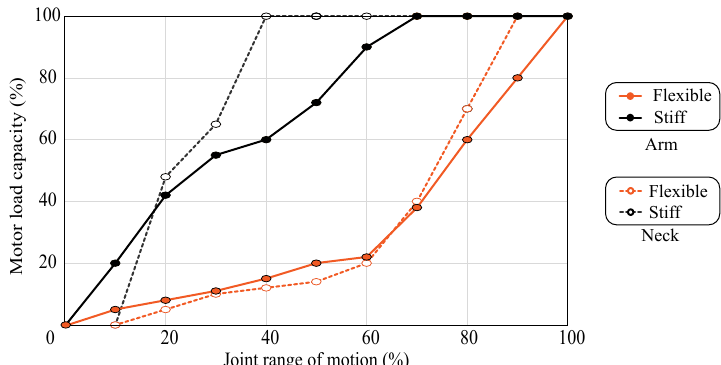
Figure 13. Motor load capacity for the neck and the arms in the blocking state. The X-axis represents the percentage of the total ROM of the element (i.e., 180 degrees for the neck and 105 degrees for the arm). The black lines represent the stiff condition for the neck (white point and segmented line) and arm (black point and continuous line). The red lines refer to the flexible condition for both parts in the same convention.